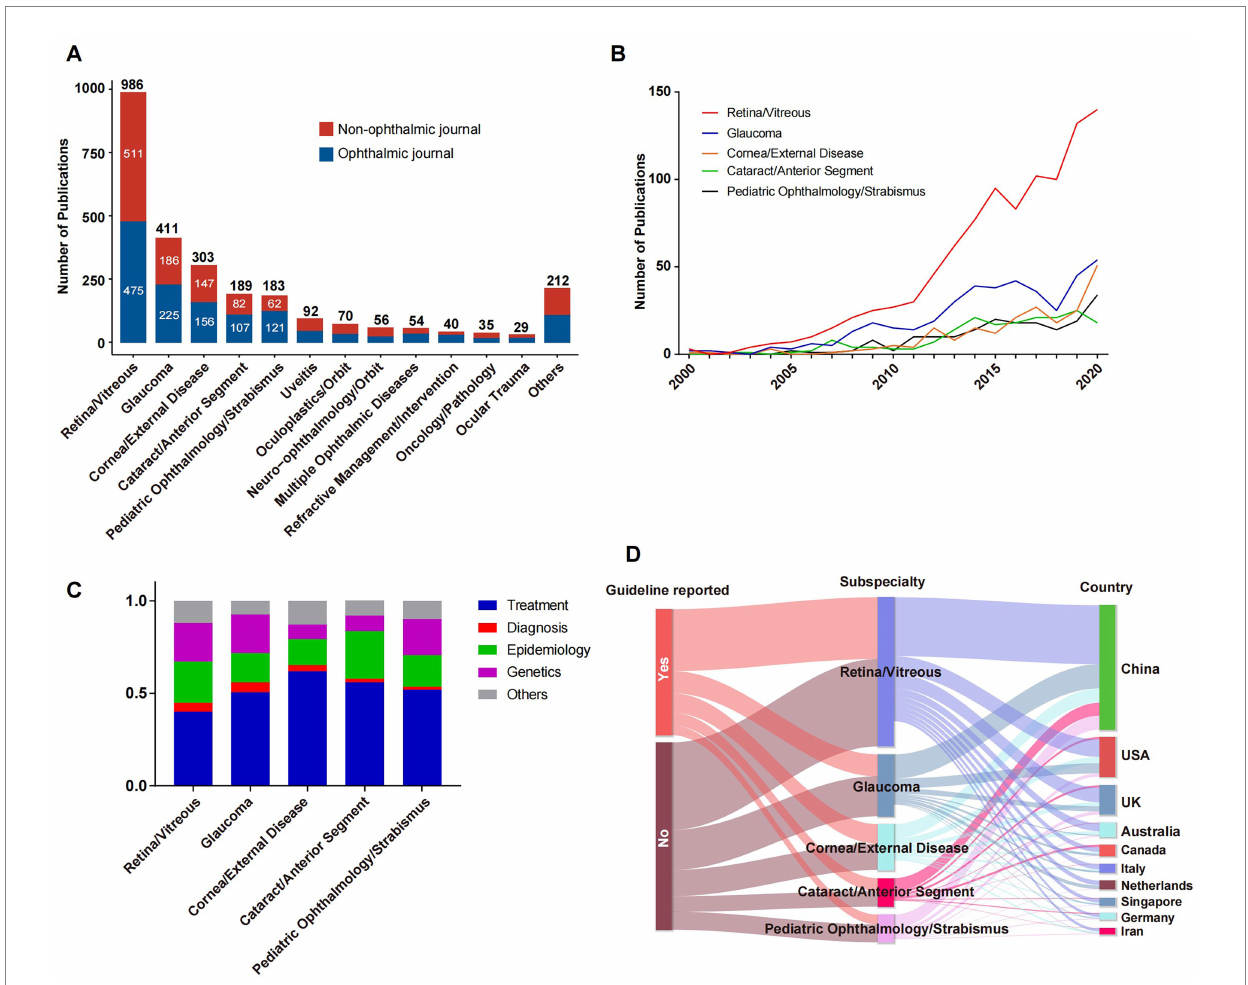
FIGURE 4 Publication in subspecialties. (A) Numbers of publications in different ophthalmological subspecialties. (B) The trends of publications in five major ophthalmological subspecialties from 2000 to 2020. (C) The proportion of different types of study content in five major ophthalmological subspecialties. (D) A Sankey diagram reveals the relationship between subspecialties and different bibliometric indicators.